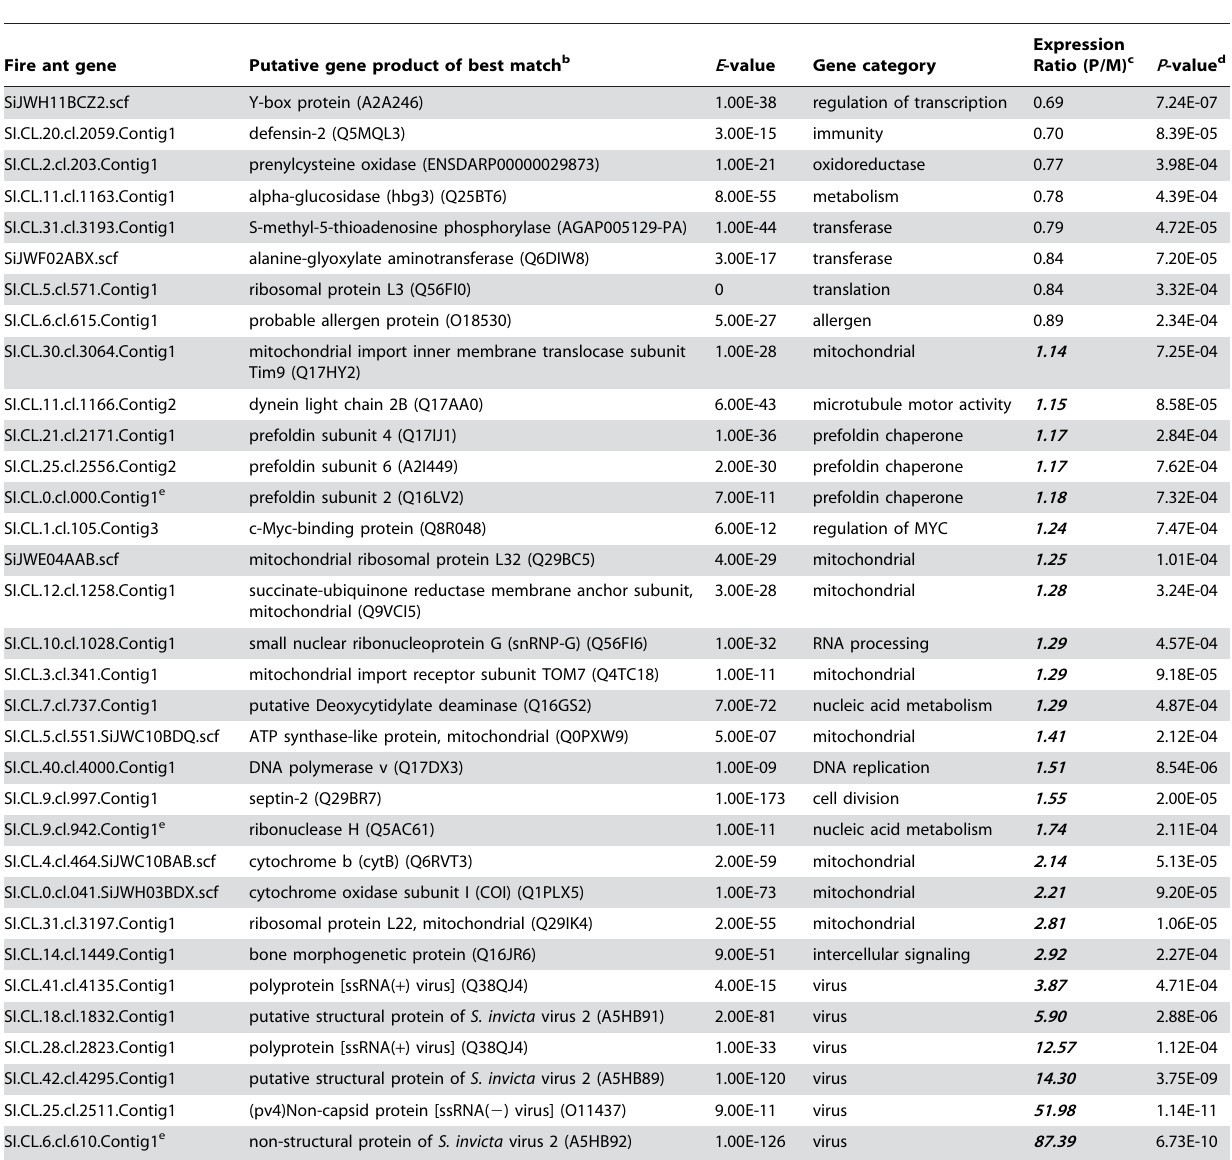
Table 2. Genes differentially expressed between S. invicta workers from monogyne and polygyne colonies bearing the BB genotype at Gp-9 that significantly match annotated genes in public databases a .